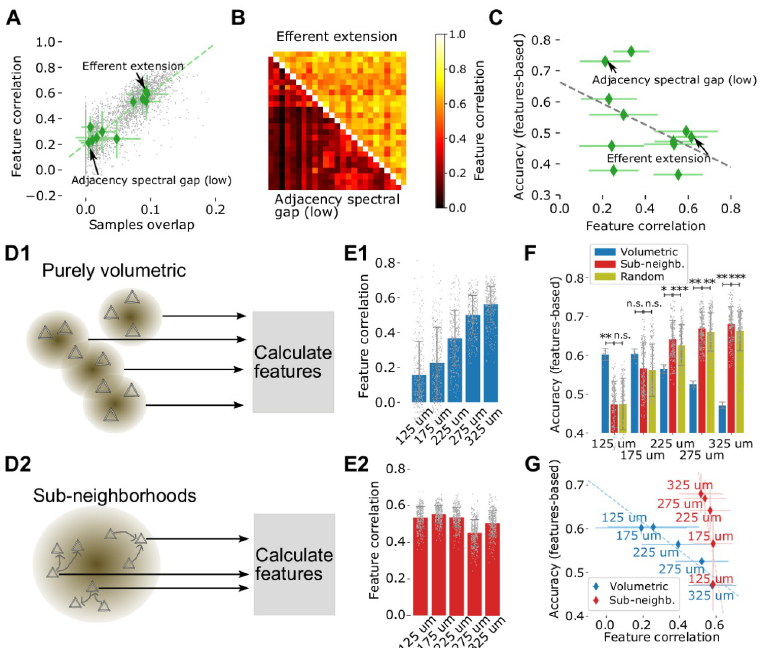
Fig 7. Feature correlation and topological featurization in volumetric samples. A: Mean relative overlap of pairs of neighborhoods that are champions of the same parameter against the mean correlation coefficient of their Euler characteristic time series ( feature correlation ). B: Pairwise feature correlations of the champions of two exemplary parameters. C: Mean feature correlation of champions against their performance in feature-based classification. D1: Feature-based classification for volumetric samples can be performed using the active sub-networks of each sample in each time step, then pooling over samples. D2: Alternatively, the 25 largest neighborhoods can be found within a single volumetric sample, which are then analyzed as other neighborhood samples. E1: Mean feature correlation for volumetric samples of various radii when the technique in D1 is employed. E2: Same, when the method outlined in D2 is employed. Only data from one volumetric sample are shown. F: Feature-based classification accuracies for volumetric samples using the purely volumetric (blue) or sub-neighborhood-based (red) techniques, or a random control for sub-neighborhoods (yellow). For sub-neighborhood-based and random conditions, we pooled data from all 25 volumetric samples. Black stars indicate Bonferroni-corrected significance (volumetric vs. sub-neighborhoods: Wilcoxon rank-sum test; sub-neighborhoods vs. random: Wilcoxon signed-rank test; n.s.: not significant, � : p < 0.01, �� : p < 0.001, ��� : p < 0.0001). G: Feature correlation against classification accuracy for volumetric samples using the purely volumetric (blue; Pearson’s r = − 0.954, p = 0.012) or sub-neighborhood-based (red; Pearson’s r = − 0.811, p = 0.096)